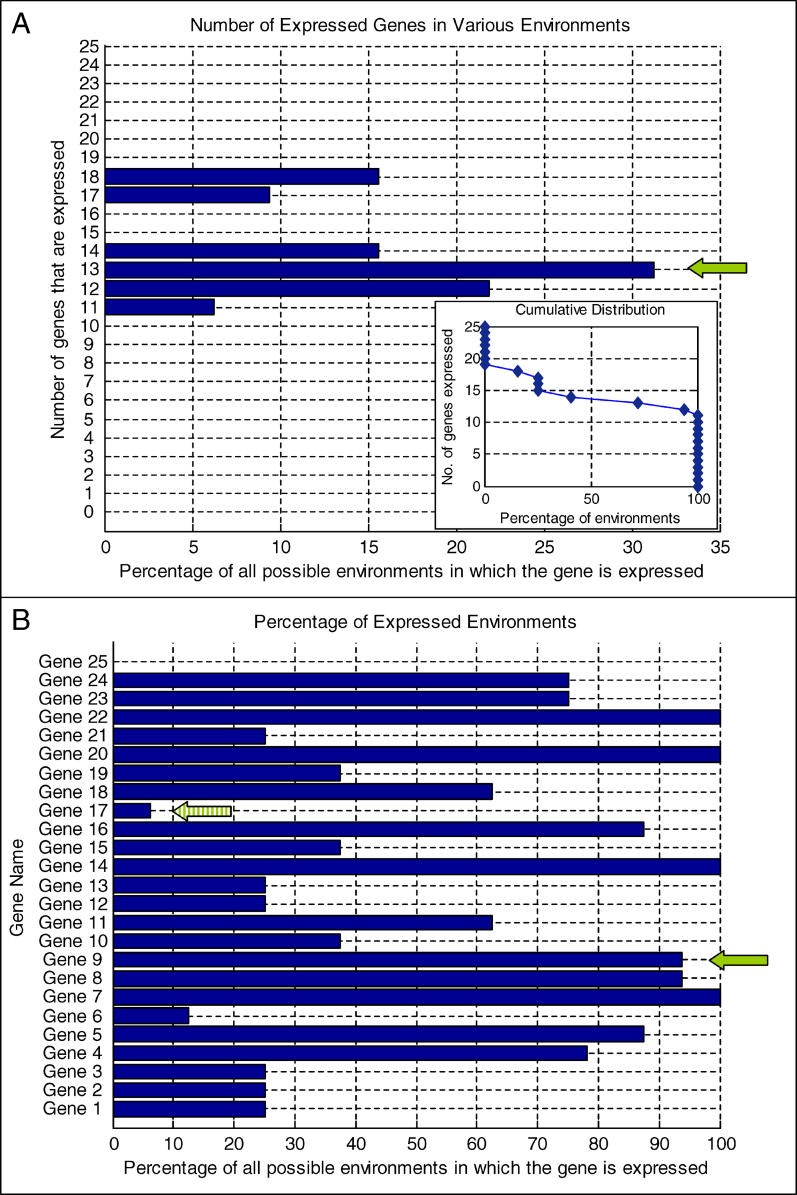
Analysis of the Prototypic TRS across All 64 [= 26, Where There Are Six Inputs] Possible Environments(A) The plot indicates the percentage of all the environments (x-axis) in which the corresponding numbers of genes are expressed (y-axis). For example, 13 genes are expressed in about 31% of the environments (as indicated by the arrow). The inset shows the cumulative distribution of the percentage of all the environments in which the corresponding number of genes are expressed. Note that, for all possible environments, there are at least 11 genes and at most 18 genes expressed, and in no environments are there either 15 or 16 genes expressed.(B) The percent of environments in which the indicated gene is expressed is shown. For example, Gene 9 is expressed in about 94% of all the possible environments (as indicated by the solid arrow). This representation of gene expression data provides insights into genes that are particularly essential or inessential for fundamental biological processes. Gene 9, for instance, is likely essential to cell survival and/or growth. By contrast, Gene 17, which is expressed in about 6% of all the possible environments (as indicated by the striped arrow), is much less essential (or its inactivation is essential) to cell survival and/or growth. These data can be used to further experimentally interrogate the system.